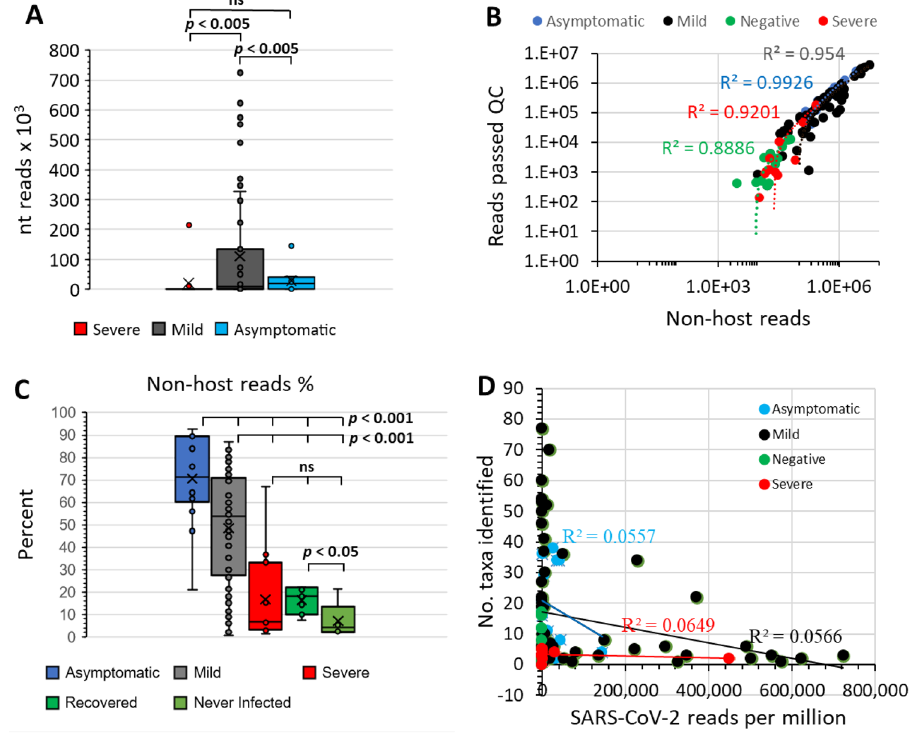
Figure 1. Cohort s equencing reads in relation to identification of non-host sequences. ( A ) Comparison of SARS-CoV-2 reads identified relative to COVID-19 symptom severity, showing that the Mild cohort had the highest SARS-CoV-2 loads. Circles indicate the data points. Results of significance comparisons between groups are indicated by p -values; ns, not significant. ( B ) Reads that passed final QC, total reads versus non-host reads. High R 2 values indicate a direct relationship between number of non-host reads and microbiota detection. ( C ) Non-host reads as a proportion of all reads that passed QC for COVID-19 cohorts. SARS-CoV-2 -negative control Recovered and Never Infected cohorts are discriminated. Circles indicate the data points. Results of significance comparisons between groups are indicated by p -values; ns, not significant. ( D ) Number of taxa identified in cohorts relative to SARS-CoV-2 reads. Library screening parameters were NT rPM) ≥ 40, nucleotide length (NT L) ≥ 100, and NR value E−15. Low R 2 values indicate poor linear relationship between SARS-CoV-2 load and identification of taxa. Data was analysed and charts produced in Microsoft Excel version